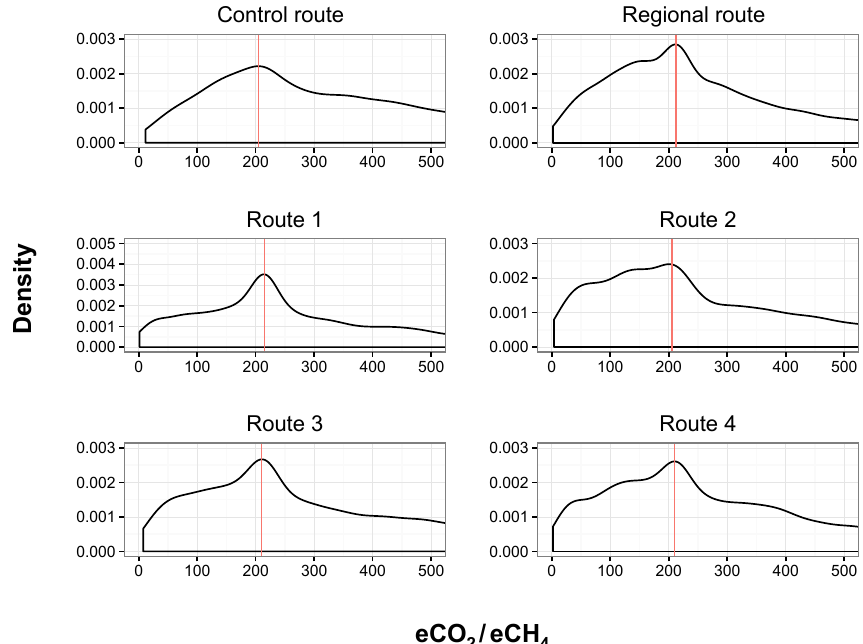
Figure 4. Kernel density plots showing the density of e CO 2 : e CH 4 measurements on each route. Red vertical lines indicate natural e CO 2 : e CH 4 values near 215. Methane-enriched peaks are visible to the left of the natural ratio on all routes except for the control, where the slope approaches zero with no peaks because we surveyed substantially less natural gas infrastructure on this route. Ratios higher than natural represent CO 2 -rich plumes which would be caused not by natural-gas-related emissions but likely by diluted car exhaust fumes or other industry types.